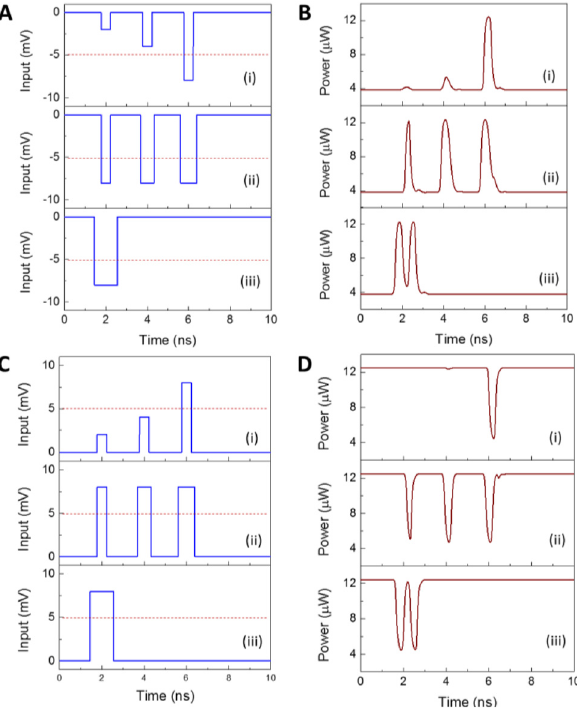
Figure 5: Optical spiking dynamic response of the neuromorphic nanoLED via high-speed nonlinear electrical (sub-10 mV) activation assuming a low surface recombination value. All-or-nothing excitatory ( B ) and inhibitory ( D ) optical spiking responses to incoming synaptic-like negative ( A ) and positive ( B ) voltage activation signals, respectively. The dashed red lines in A and C indicate the threshold level above which all-or-nothing spiking response is triggered.